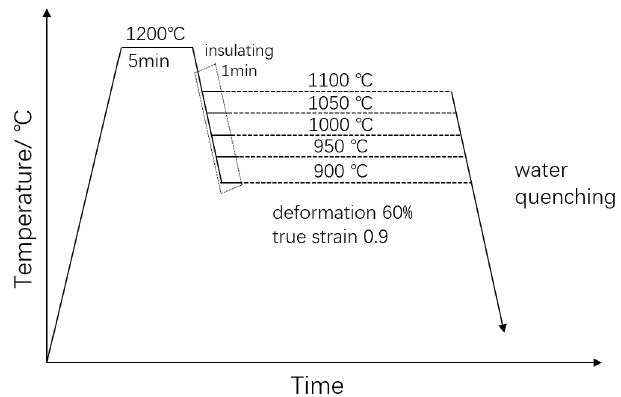
Figure 1. Schematic experimental procedures of hot deformation.